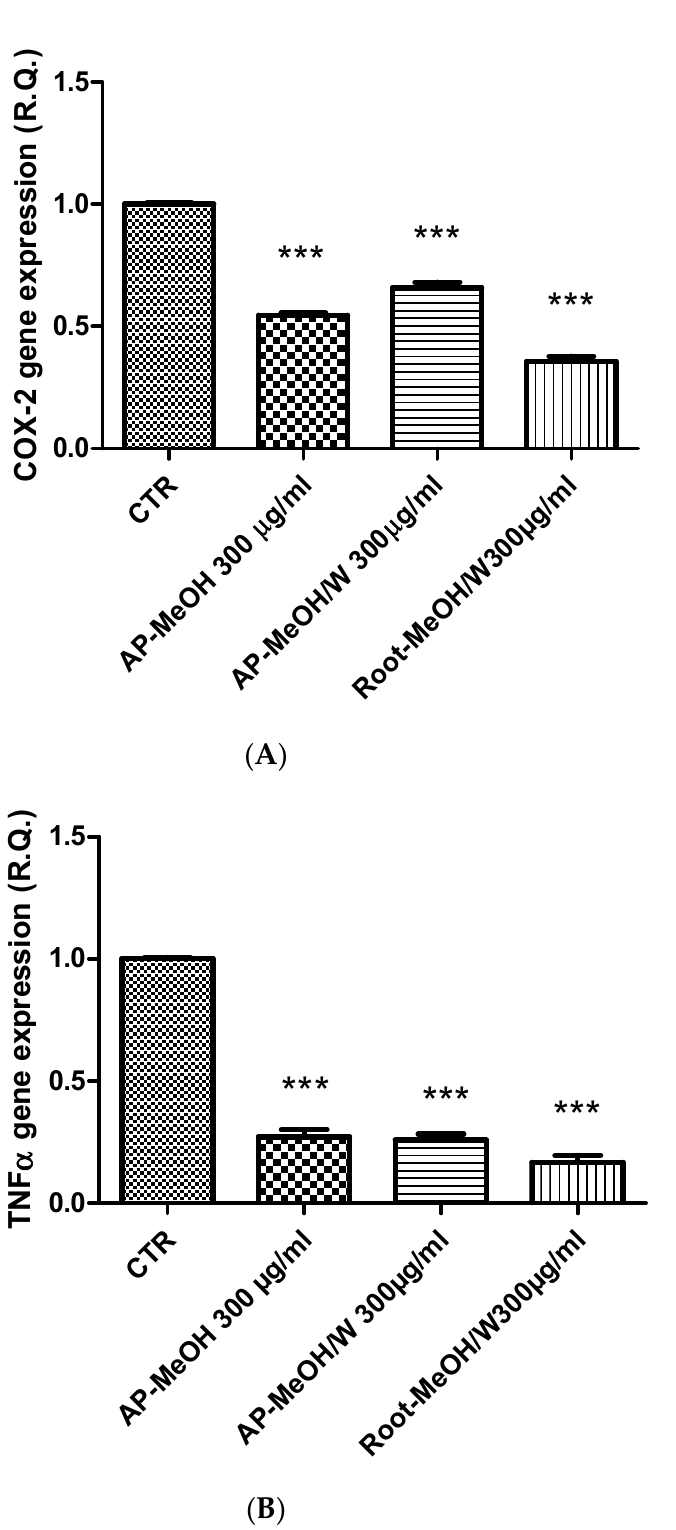
Figure 3. Inhibitory effects of COX-2 ( A ) and TNF α ( B ) gene expression induced by the methanol (MeOH) and methanol/water (MeOH/W) extracts of aerial parts (AP) and roots from Epilobium hirsutum (100–300 µg/mL). ANOVA, p < 0.0001, *** p < 0.001 vs. CTR (Control) group.